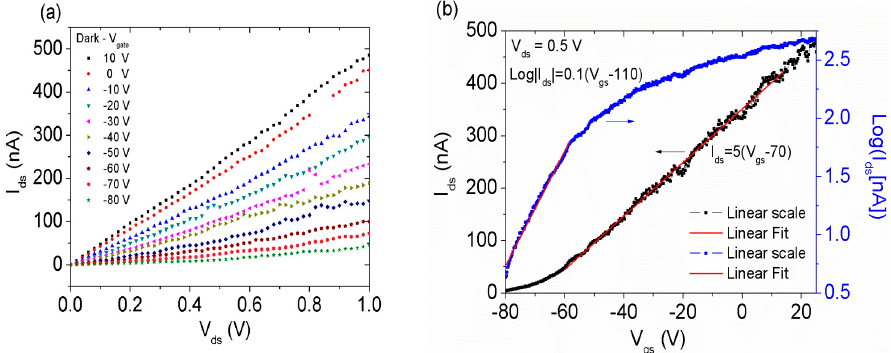
Figure 2. ( a ) Output characteristics I (cid:2914)(cid:2929) − V (cid:2914)(cid:2929) of the MoS (cid:2870) transistor for different values of the gate bias V (cid:2917)(cid:2929) ; ( b ) Transfer characteristic I (cid:2914)(cid:2929) − V (cid:2917)(cid:2929) (left scale) and Log|I (cid:2914)(cid:2929) | − V (cid:2917)(cid:2929) (right scale) with linear fittings.